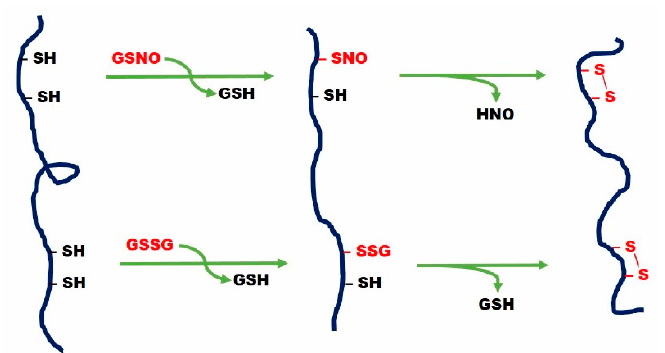
Figure 5. Schematization of modified cysteines on a polypeptide. The upper side represents the nitrosylation due to GSNO. The lower side represents the glutathionylation due to GSSG.